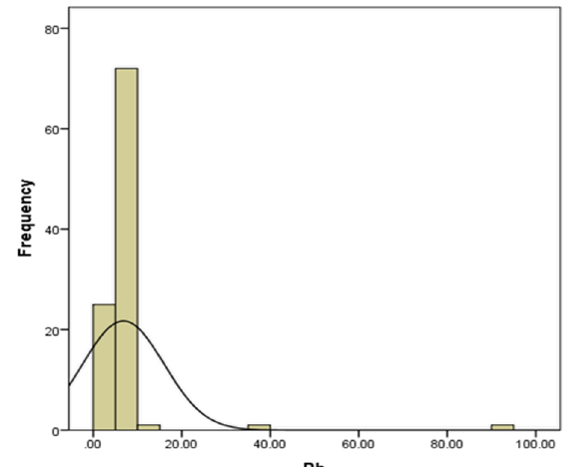
Fig. 1. Distribution of Pb in breast milk at 2nd postpartum, µg/l (n=100)